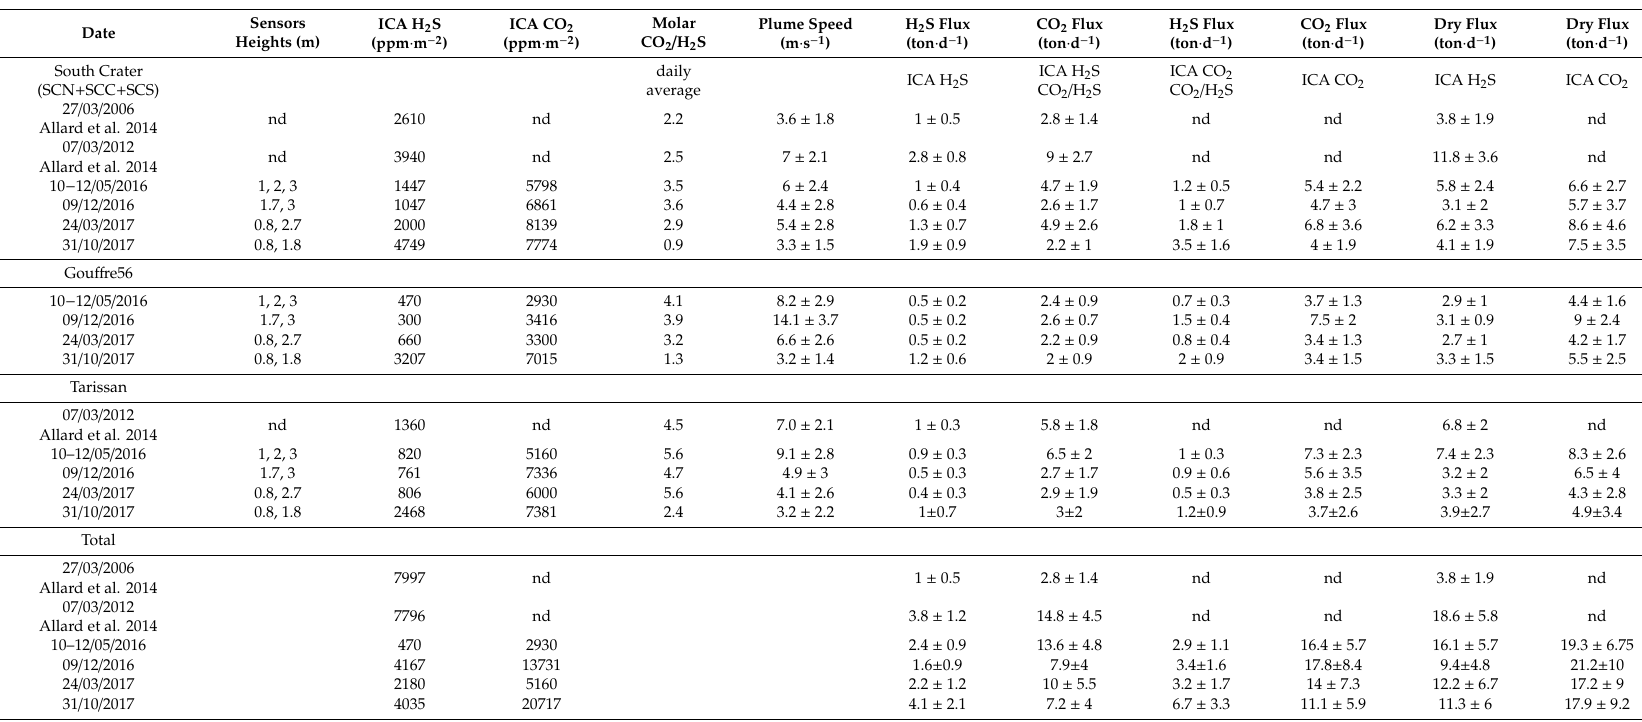
Table 2. CO 2 and H 2 S gas fluxes at La Soufri è re in 2016–2017 computed from both CO 2 and H 2 S ICAs and CO 2 / H 2 S average molar ratios (see Section 4.1). Dry gas flux is calculated as the sum of CO 2 and H 2 S. The sensor heights above the ground during MultiGAS traverses and the wind speed used for gas flux calculation are